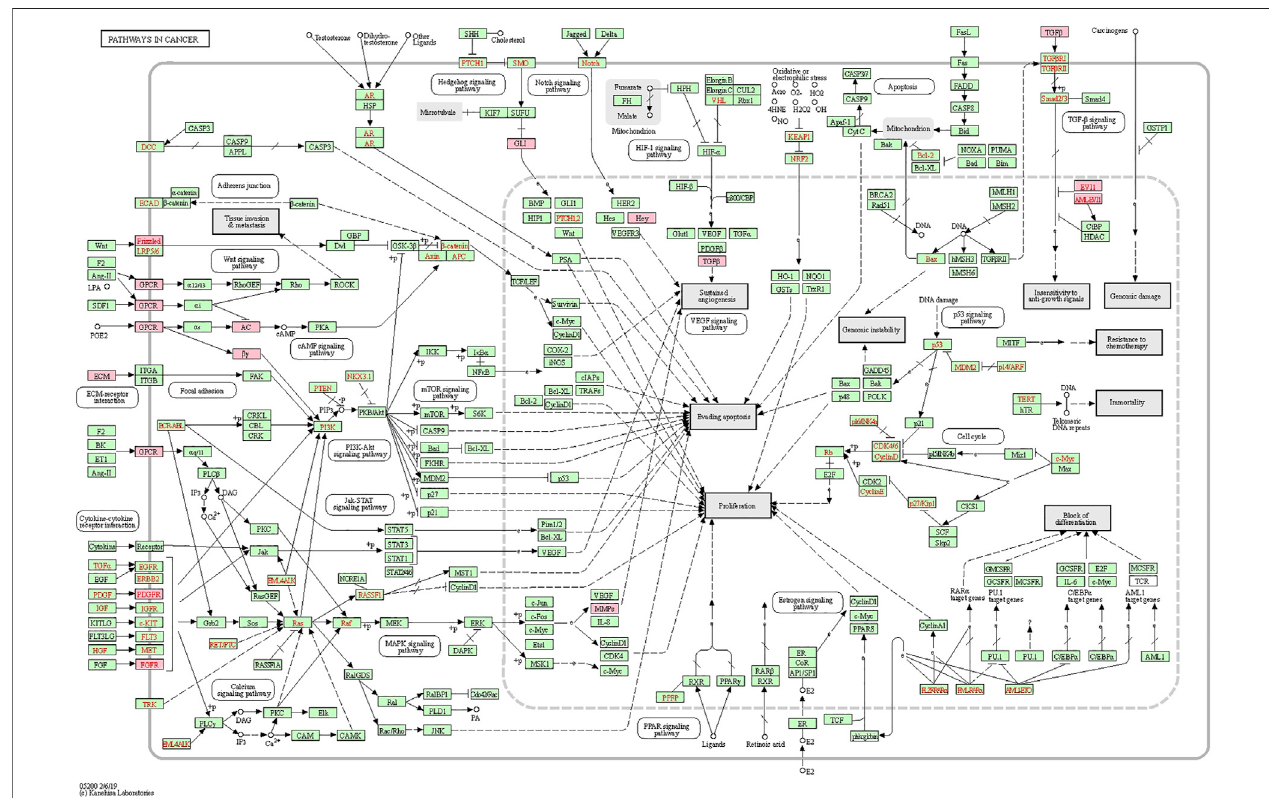
FIGURE 9 | Positional relationship of LOXs co-expressed genes in the cancer network. The overlapping genes were mainly enriched in cancer-related pathways, such as pathways in cancer (hsa05200), PI3K-AKT signaling pathway (has04151), focal adhesion (has04510), ECM-receptor interaction (hsa04512). The relevant positions of the corresponding genes in the pathway are marked with pink